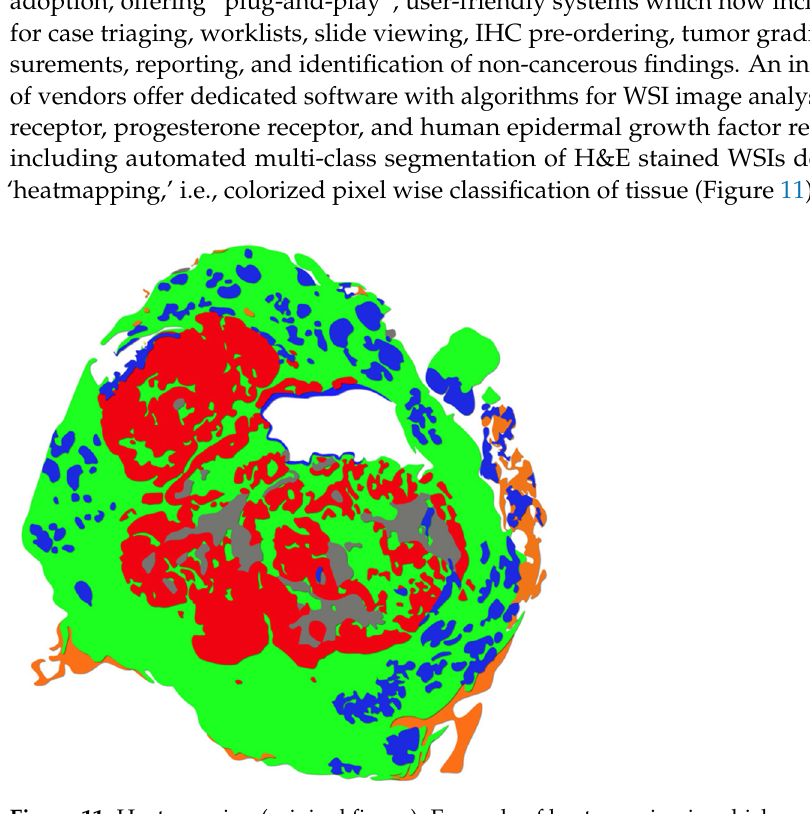
Figure 11. Heatmapping (original figure). Example of heatmapping in which spatial information is delineated by colors indicating carcinomatous region (red), benign epithelium (blue), stroma (green), adipose (orange), and areas of necrosis (gray) on a WSI specimen.